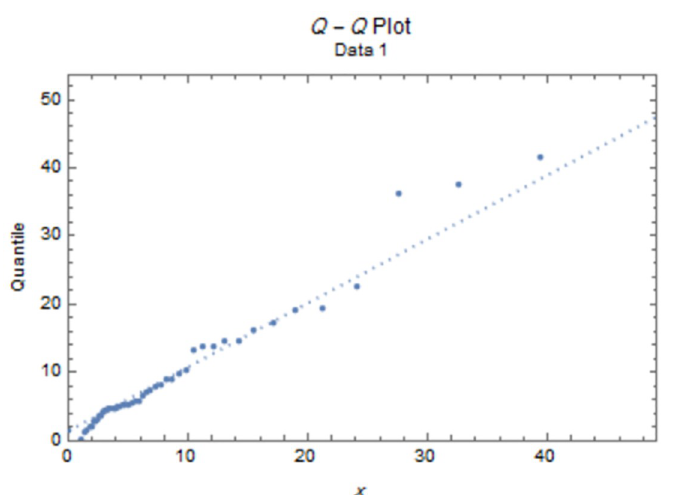
Fig 12. Q-Q plot for data 1.